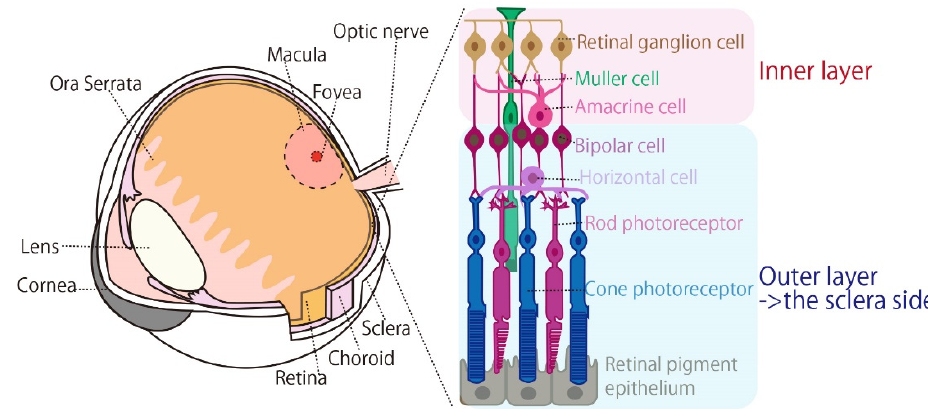
Figure 1. Anatomic information inside the human eyeball [8,14].